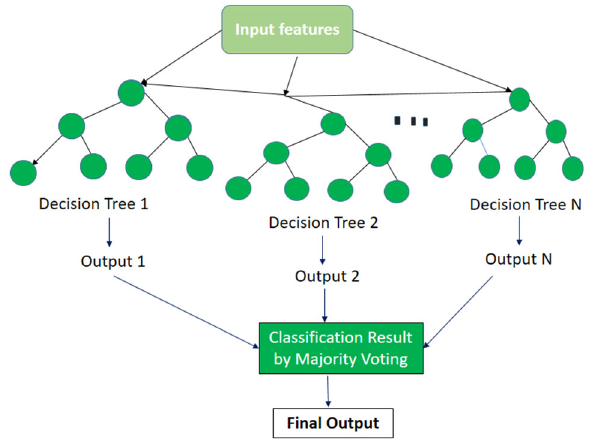
Figure 8. Proposed HPAR model from the random forest classifier.